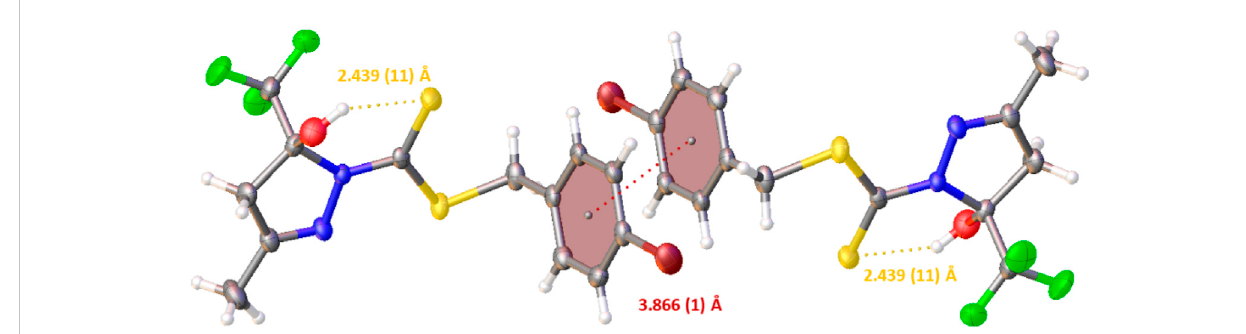
Molecular structure of the complexes (1 – 4) with crystallographic labeling (30% probability